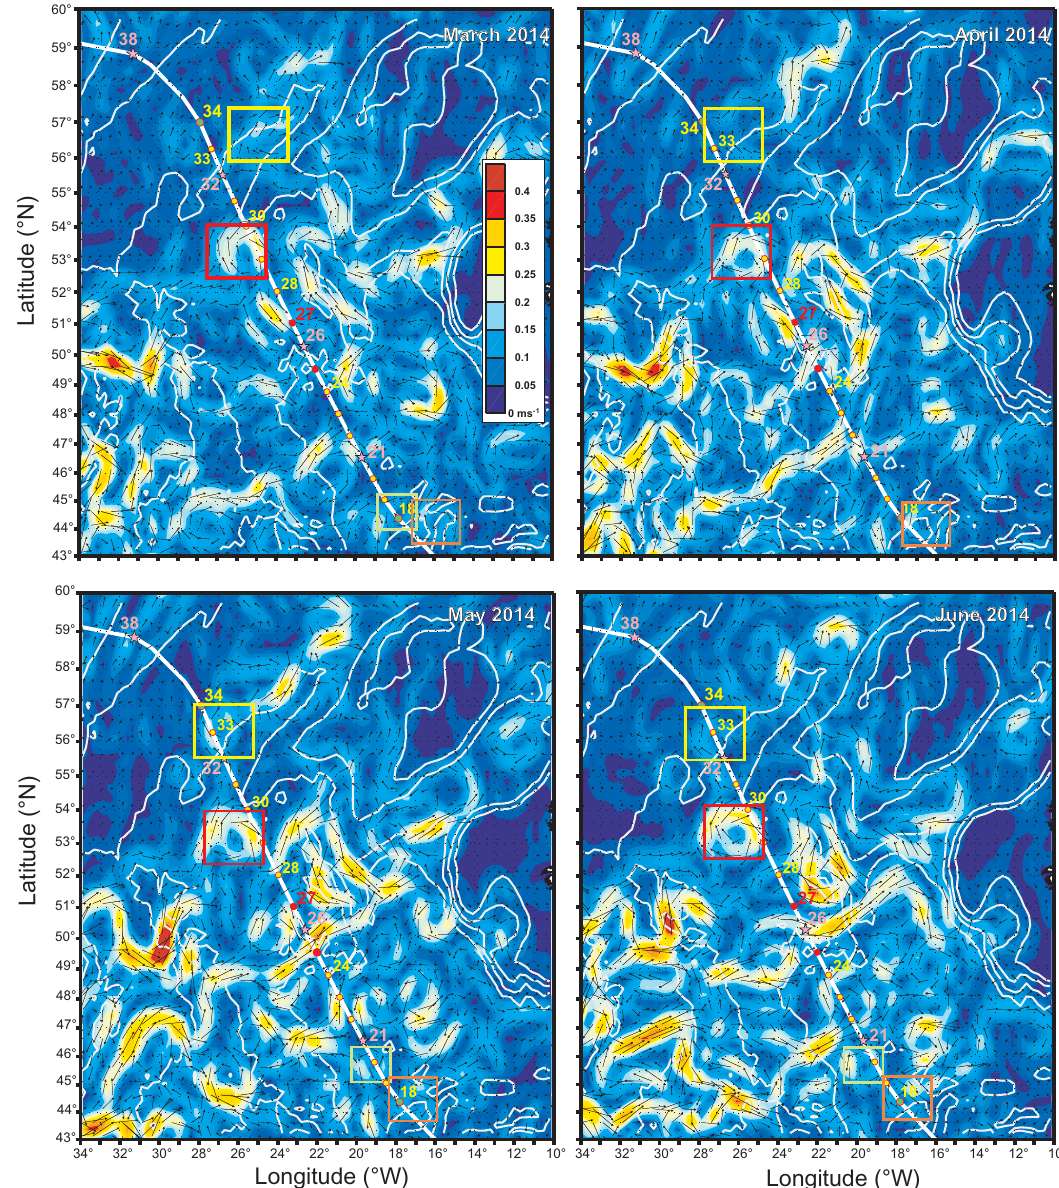
Figure 6. Surface velocities derived from AVISO data, as in Fig. 5 but zooming in on the NAC region in March, April, May, and June 2014. The yellow, red, clear green, and orange squares indicate the position of the northern, central, southern cyclonic, and southern anticyclonic eddies, respectively, discussed in Sect. 3.2. The numbers of the GEOVIDE stations are indicated in all the plots: pink for the super stations and XL stations and yellow for regular stations. The red and green points delimit the position of the SAF and the NAC, respectively, during the period of the GEOVIDE cruise. The bathymetry contours every 1000m are indicated by light white